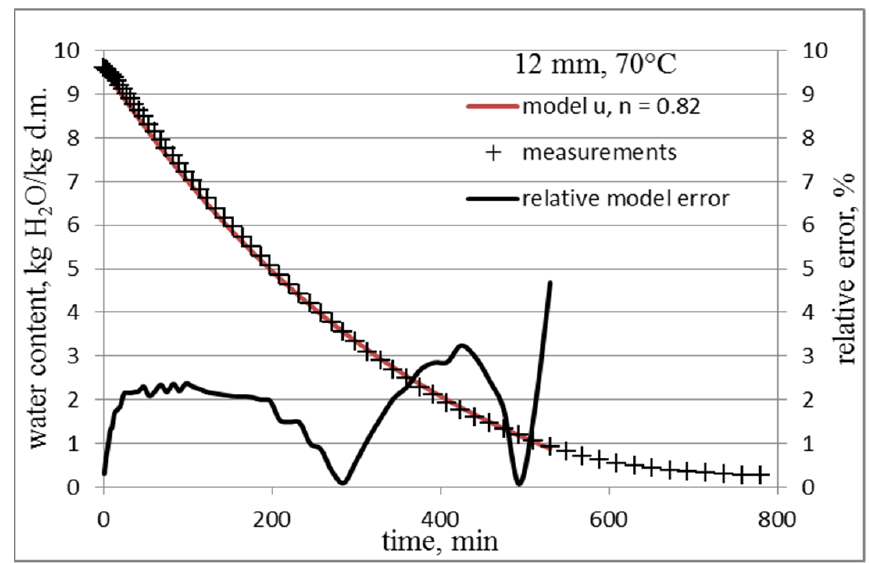
Figure 3. Model of water content changes in leek slices 12 mm thick, during drying at temperature 70 ◦ C, when n =